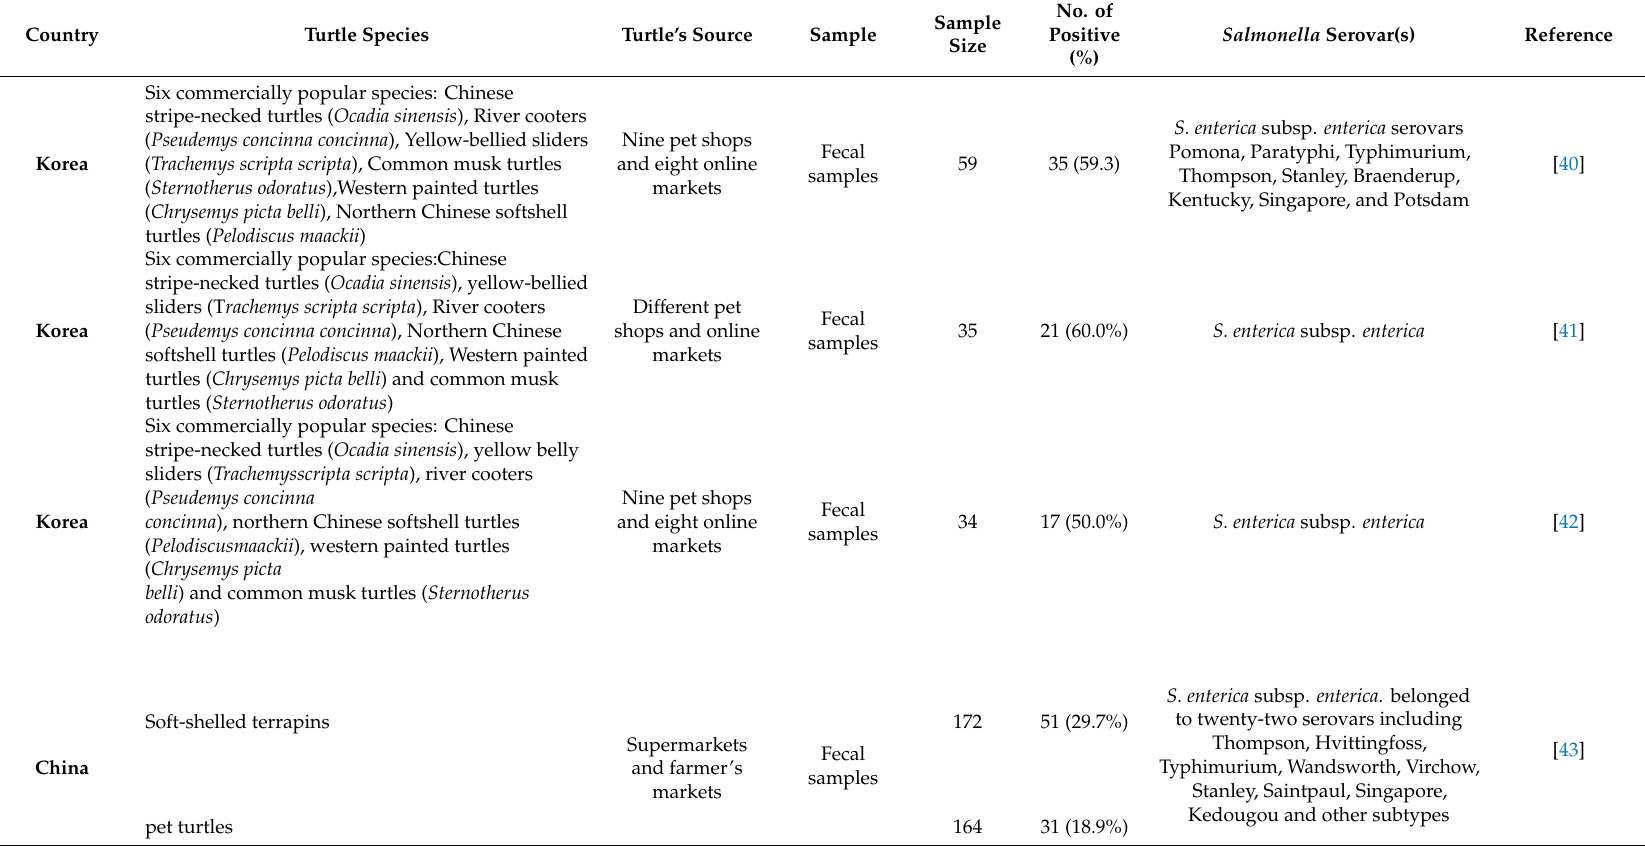
Table 3. Salmonella recovery from di ff erent turtle species around the world in the last ten